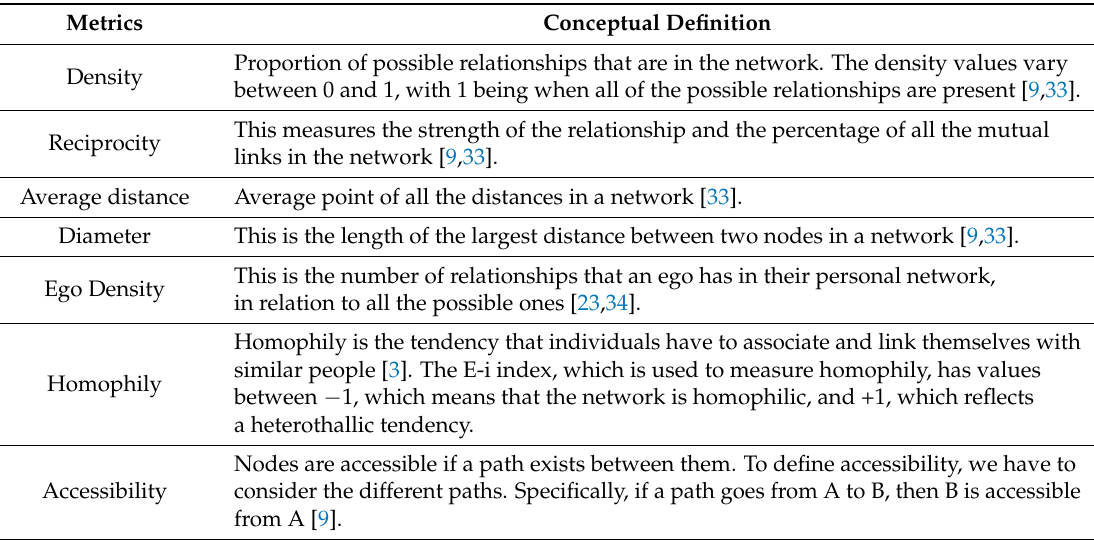
Table 2. Cohesion metrics and conceptual